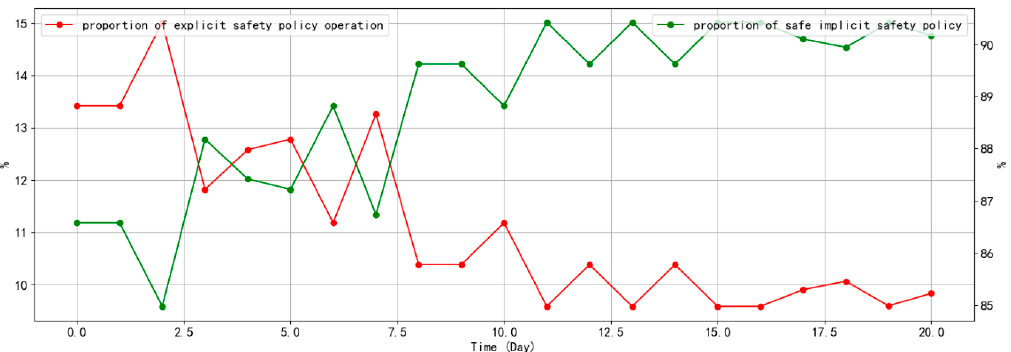
Figure 13. The proportion of explicit safety policy operation and safe implicit safety policy.